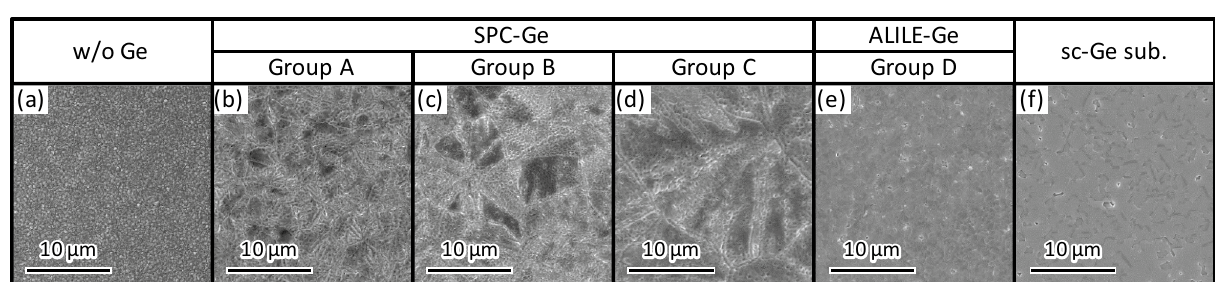
Figure 3. Surface SEM images of GaAs layers. ( a ) GaAs layer grown on glass without Ge seed layer, ( b ) sample in Group A ( T anneal = 375 °C), ( c ) sample in Group B ( T anneal = 375 °C), ( d ) sample in Group C ( C As = 1.2 × 10 20 cm −3 ), ( e ) sample in Group D ( t AE = 3 min), and ( f ) GaAs layer grown on sc-Ge wafer. The samples were wet etched for 10 min to enhance grain boundaries and reveal